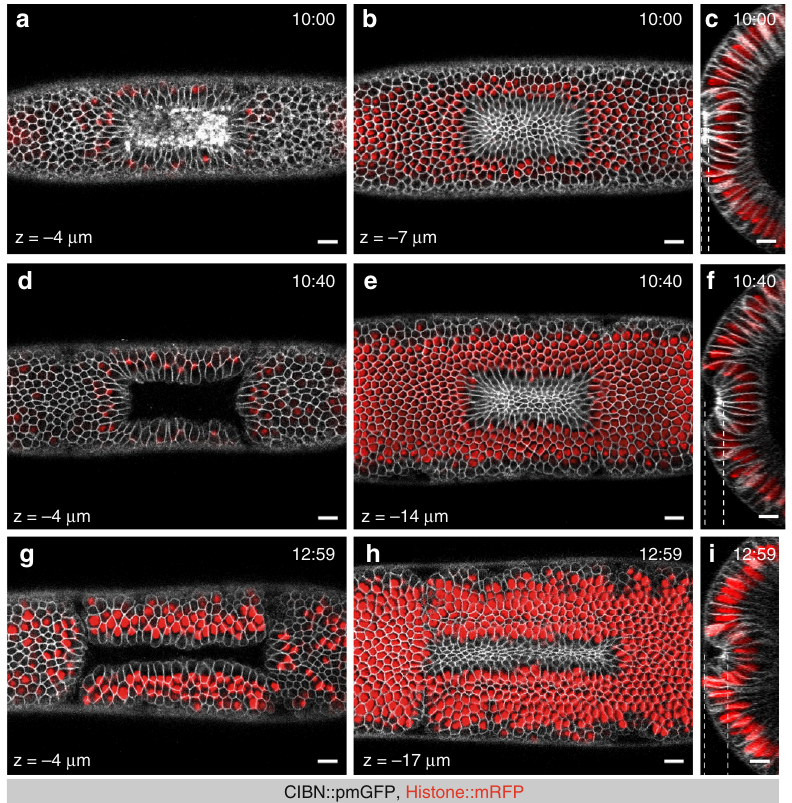
Fig. 5 Sustained RhoGEF2 optogenetic activation is suf fi cient to drive a complete invagination. a – i Confocal images of three individual embryos co- expressing CIBN::pmGFP, RhoGEF2-CRY2, and Hist2A::mRFP as nuclear marker. Within a rectangular on the dorsal epithelium, two-photon illumination was restricted to three consecutive z-stacks (1 µ m spacing) centered at 4 µ m from the apical-most plane, and excited for ~152 ms during each acquisition round. Sustained photo-activation was alternated with mCherry excitation at intervals of ~13 s. As the epithelium folded inwards, continuous two-photo- activation was achieved by manually adjusting the ROI such that illumination was restricted to the initial group of photo-activated cells. In addition, the focal plane of activation was manually recti fi ed to match the cells ’ apical-most plane. At the indicated time points, a z-stack comprising the dorsal epithelium was acquired for both mRFP and GFP (50 planes, 1 µ m spacing). Overlays of both channels are shown. a – c Three views of the dorsal epithelium after 10:00 min of continuous activation. a Surface view of the dorsal epithelium at a depth of 4 µ m. b Apices of activated cells at a depth of 8 µ m. c Cross- section view of the activated area. d – f Three views of the dorsal epithelium after 10:48 min of continuous activation. d Surface view of the dorsal epithelium at a depth of 4 µ m. e Apices of activated cells at a depth of 14 µ m. f Cross-section view of the activated area. g – i Three views of the dorsal epithelium after 12:59 min of continuous activation. g Surface view of the dorsal epithelium at a depth of 4 µ m. h Apices of activated cells at a depth of 17 µ m. i Cross- section view of the activated area. Dashed lines indicate the depths at which surface views were acquired (left and middle panels). Scale bars, 10 µ